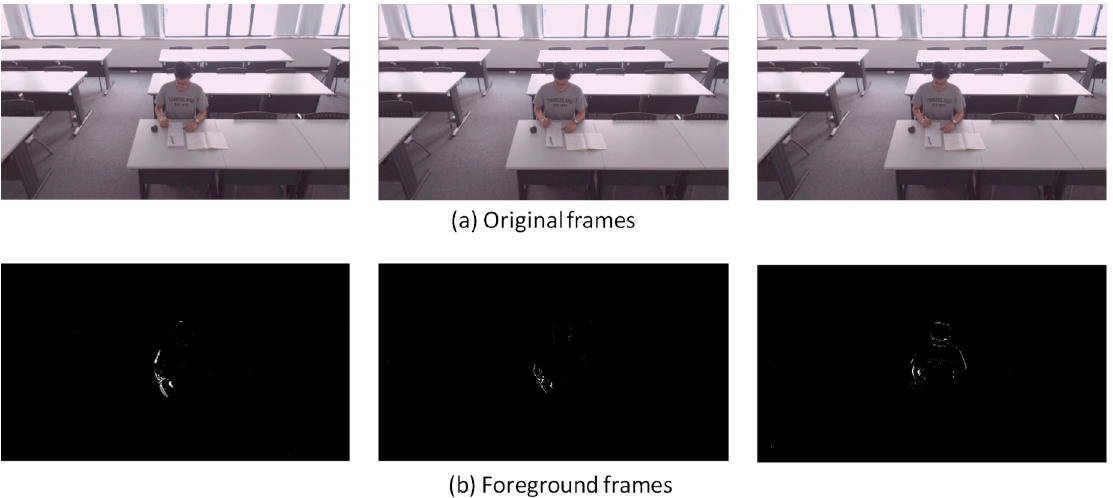
Figure 12. Reading and/or writing—sample images.